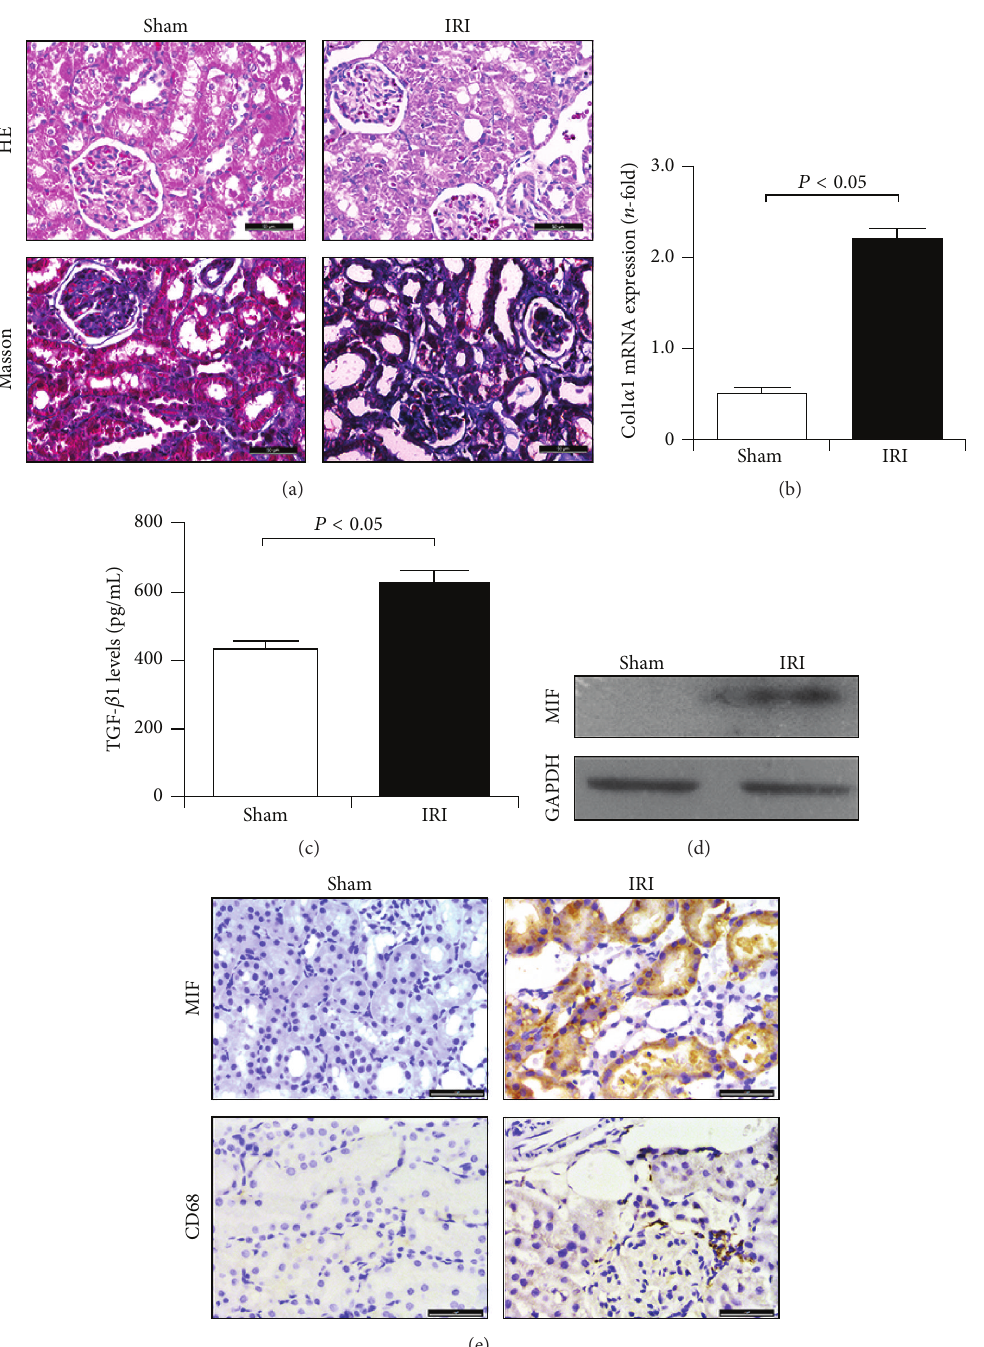
Figure 3: Matrix deposition and MIF expression were enhanced in IRI kidneys. (a) HE and Masson staining revealed marked inflammatory cell infiltration and interstitial injury in IRI kidneys tissues of BUO rats. Bar: 50 𝜇 m. (b) Gene expression of type III collagen in IRI kidneys was upregulated. (c) IRI induced the upregulation of TGF- 𝛽 1 levels in IRI kidneys. (d) IRI induced upregulated expression of MIF in IRI kidneys. (e) Increased expression of MIF and CD68 in kidneys of IRI rats. Bar: 50 𝜇 m.